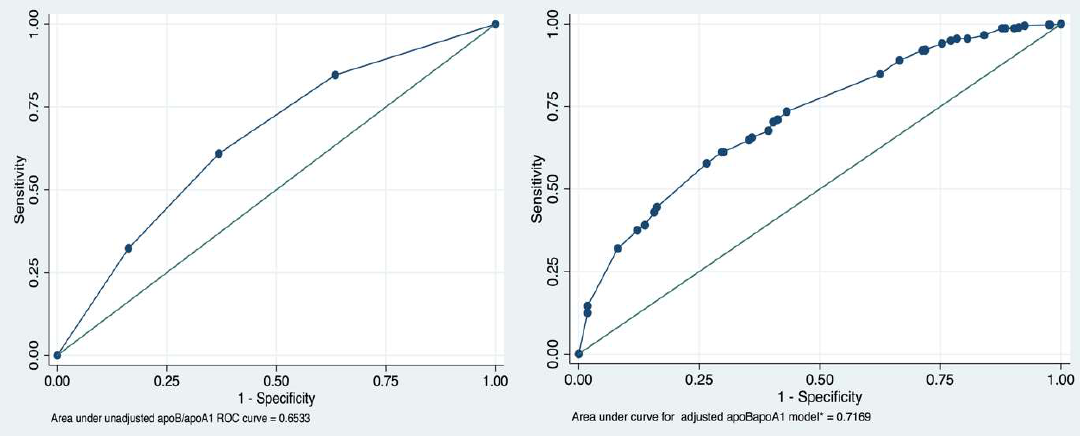
Figure 1. Receiver operating characteristic (ROC) curves and area under the curve (AUC) for the ApoB/ApoA1 ratio in unadjusted and adjusted regression logistic models for the association between MS and ApoB/ApoA1 ratio.